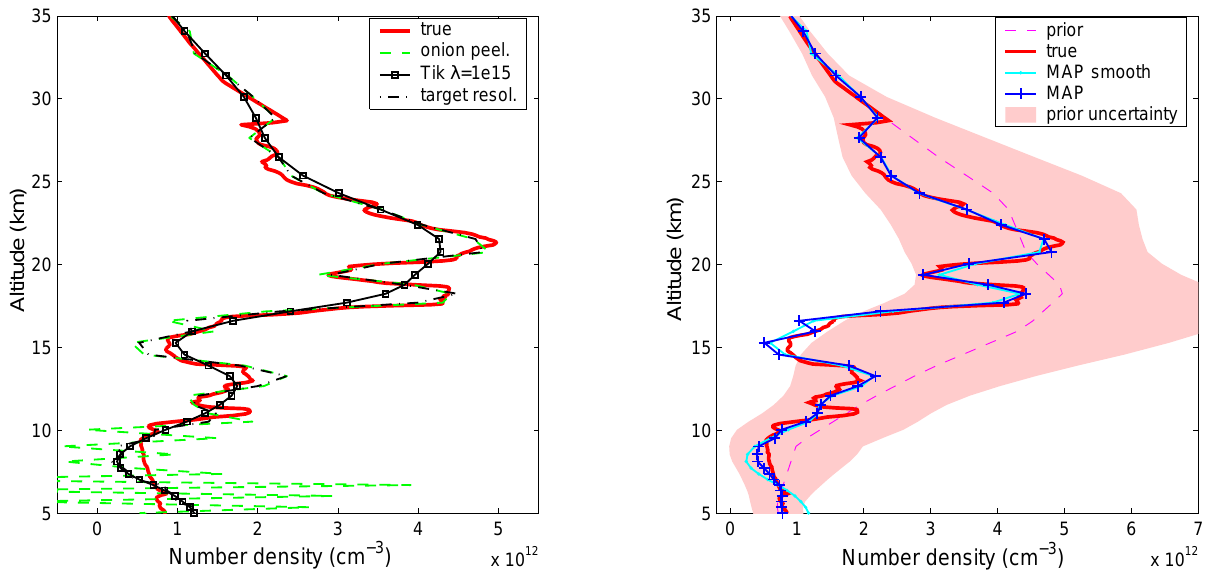
Fig. 5. Reconstruction of ozone profile with different methods for the lower atmosphere. Left plot: onion peeling, Tikhonov regularization with regularization parameter λ = 10 15 chosen according to the Morozov’s discrepancy principle and with the regularization parameter chosen according to the target resolution; Right plot: MAP with smoothness a priori (MAP smooth) and classical MAP methods.